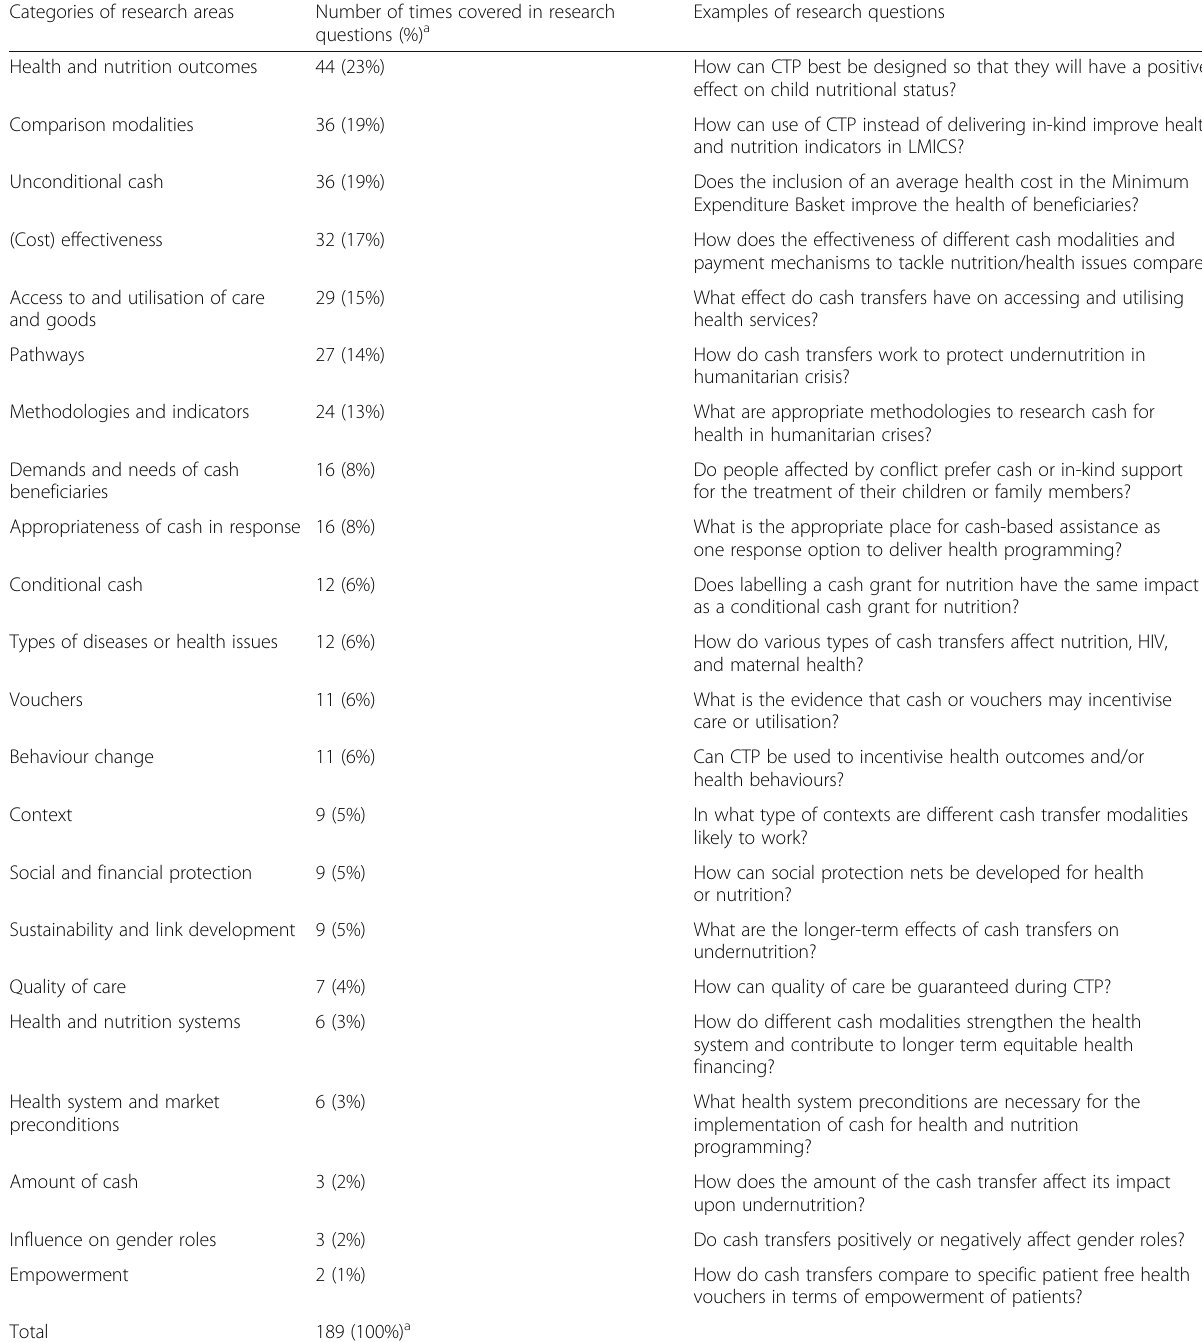
Table 3 Number of consulted research questions for each category, including examples of research questions Categories of research areas Number of times covered in research questions (%)